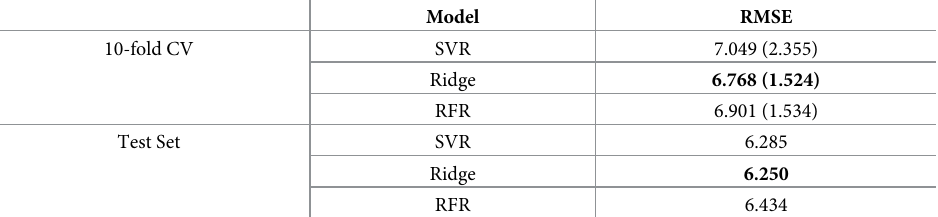
Table 6. MMSE prediction in terms of RMSE scores for three different models (SVR, Ridge and RFR) using acous- tic features on the 10-fold CV (top) with standard deviation and on the inference on test set (bottom). Bold indi- cates the best RMSE score.